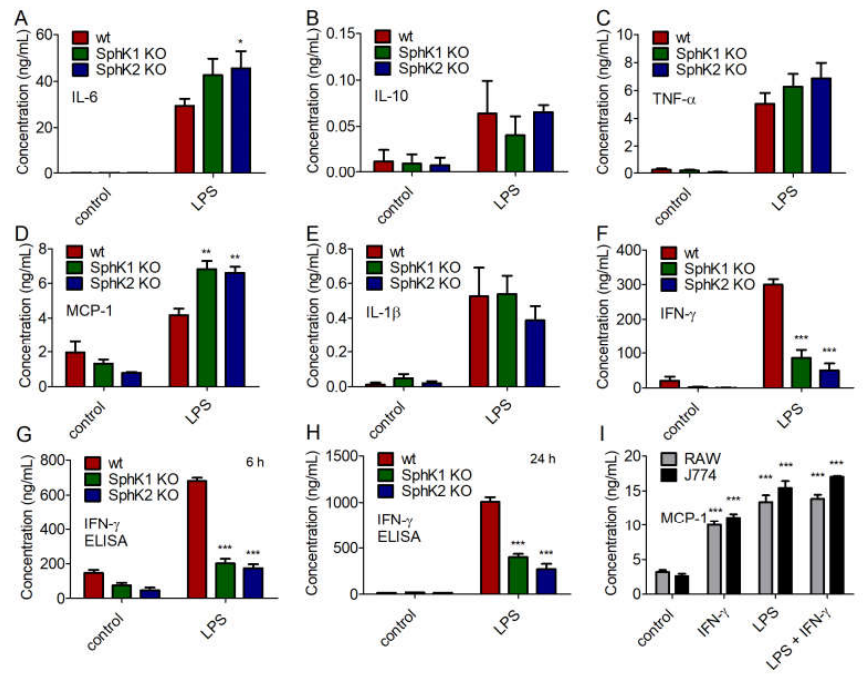
Figure 6. Concentration of ( A ) IL-6, ( B ) IL-10, ( C ) TNF- α , ( D ) MCP-1, ( E ) IL-1 β , and ( F ) IFN- γ in BMDC derived from wt, SphK1 − / − and SphK2 − / − mice unstimulated (control) and 24 h after stimulation with 10 µ g/mL LPS, determined by cytometric bead array (CBA, BD Biosciences). Reduced levels of IFN- γ in BMDC derived from SphK1 − / − and SphK2 − / − mice compared to wt mice as shown in ( F ) were confirmed by ELISA ( G ) 6 h and ( H ) 24 h after stimulation with 10 µ g/mL LPS. Significances were calculated between cells derived from wt mice and those derived from SphK1/2 deficient mice in the respective control or LPS-treated groups using two-way ANOVA with Bonferroni posttest, n ≥ 3, * p < 0.05, ** p < 0.01, *** p < 0.001. ( I ) Concentration of MCP-1 in RAW264.7 and J774.1 murine macrophage cell line supernatant after overnight stimulation with 10 ng/mL IFN- γ and/or 100 ng/mL LPS. Significances were calculated between control and stimulated cells using the two-tailed unpaired Student’s t -test, n =